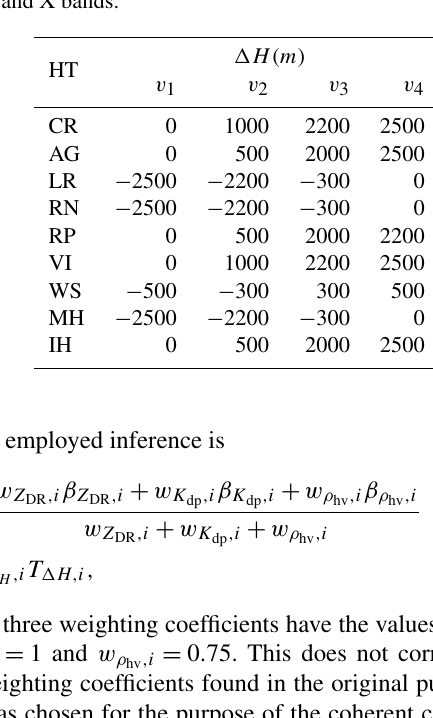
Table A3. Trapezoid membership function parameterisation for both C and X